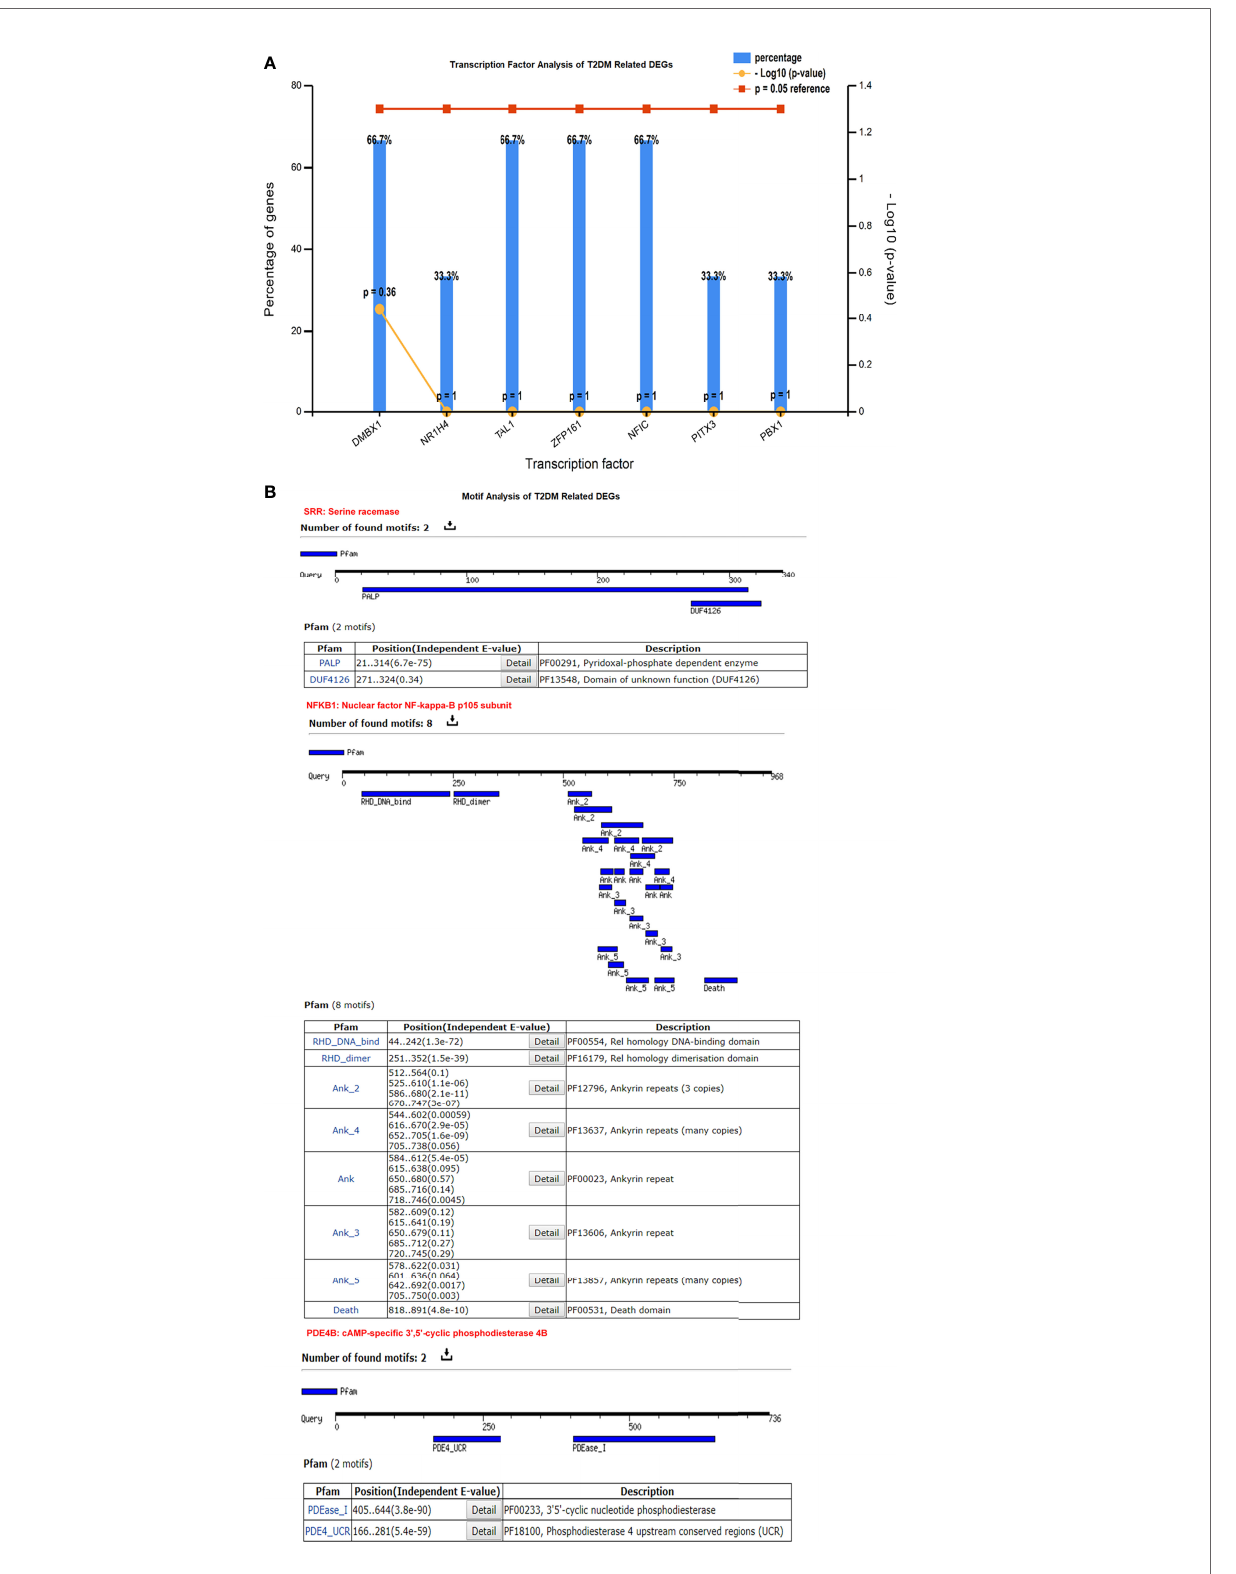
FIGURE 4 | (A) Transcriptional factors of the differentially expressed genes (DEGs) showing DMBX1 , TAL1 , ZFP161 , NFIC , and other regulatory factors. (B) Motif analysis highlights a signi fi cant number of functional motifs associated with important biological